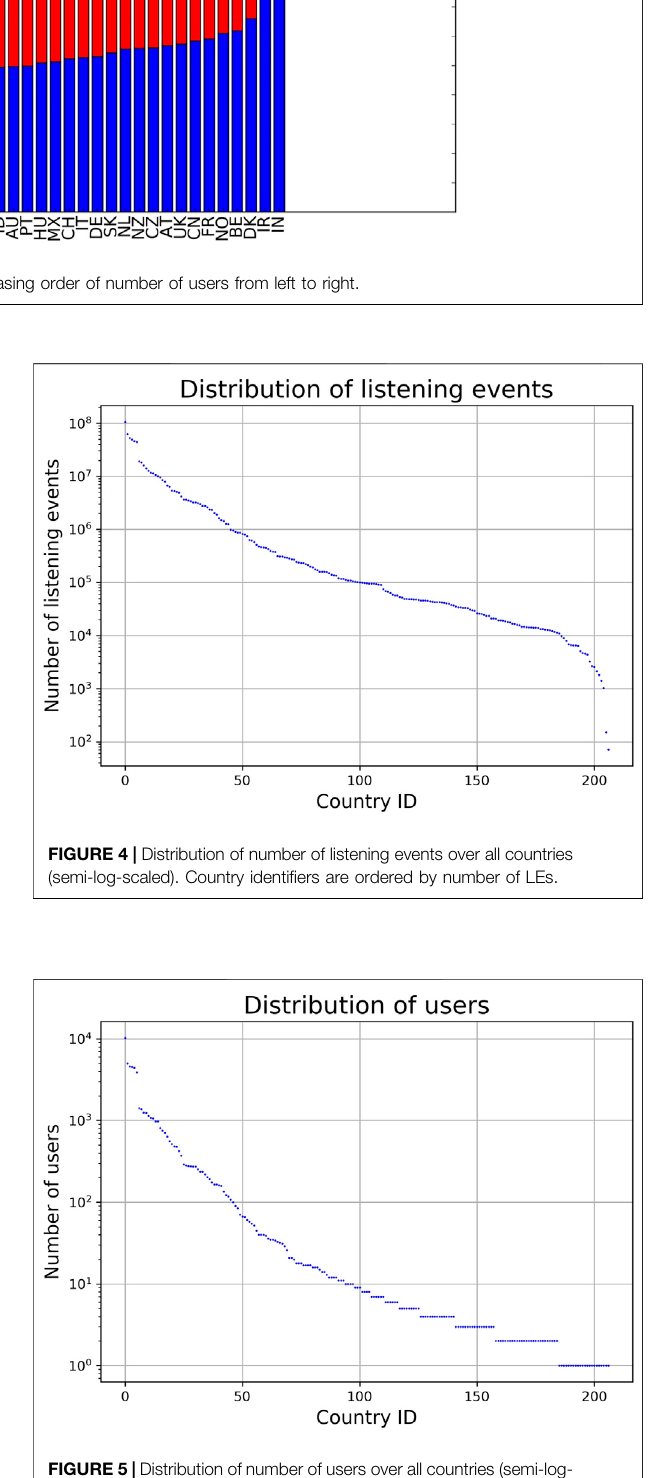
FIGURE 5 | Distribution of number of users over all countries (semi-log- scaled). Country id ordered by number of